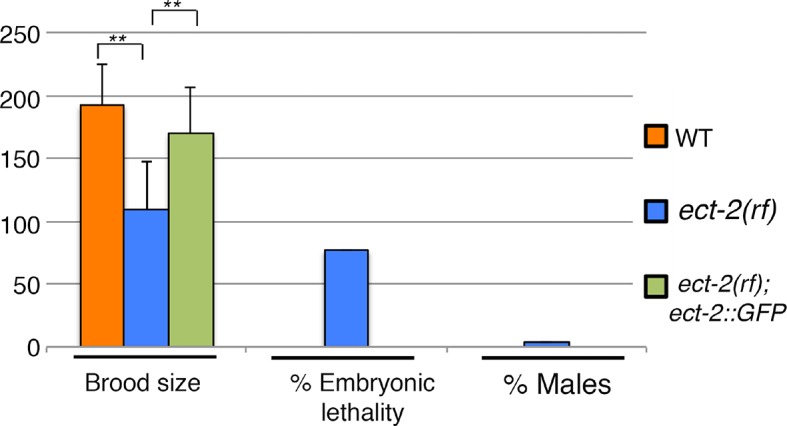
Rescue of ect-2(ax751rf) phenotypes by expression of functional ECT-2::GFP in the germline.Histogram showing brood size, embryonic lethality and Him (High Incidence of Males) phenotype in wild type, ect-2(ax751rf), and ect-2(ax751rf) mutant animals expressing ECT-2::GFP. ECT-2::GFP is able to rescue brood size, embryonic lethality and the Him phenotype of ect-2(ax751rf) mutants at the non-permissive temperature. **p<0.0001 (unpaired student’s t-test). 20, 30 and 20 gonad arms were analyzed for wild type, ect-2(ax751) and ect-2(ax751); ECT-2::GFP animals, respectively. ECT-2::GFP has been shown to rescue the sterility phenotype of ect-2(gk44) null mutants in Chan and Nance (2013). Brood size indicates the total number of eggs (non-hatched and hatched) laid per hermaphrodite. All worms from the indicated genotypes, except ect-2(ax751);ECT-2::GFP, were grown at 15°C and shifted to 25°C as L4 worms. ect-2(ax751) animals expressing ECT-2::GFP were grown at 20°C to prevent silencing of the transgene and shifted as L4 animals to 25°C. All genotypes were analyzed 18–24 hr post-L4 at 25°C.